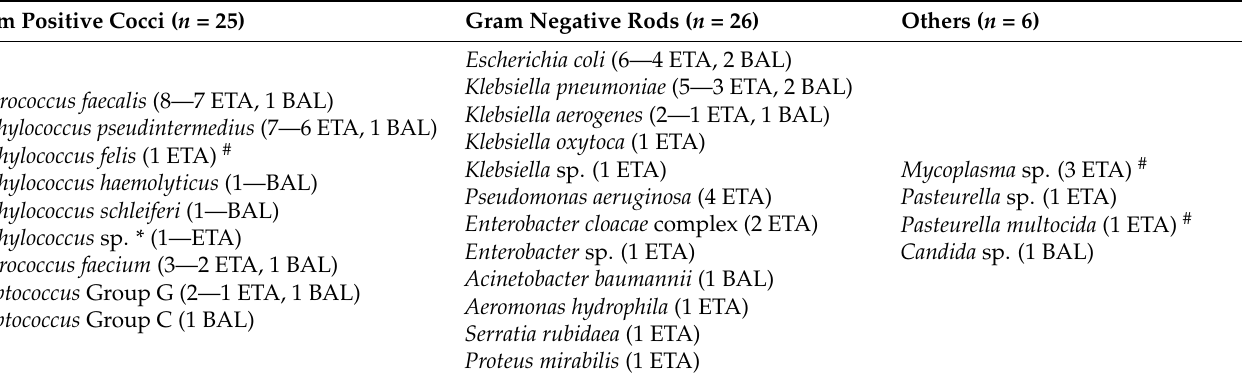
Table 1. Classification and numbers of microorganisms cultured from the airways of dogs and cats with tick paralysis during mechanical ventilation, obtained by endotracheal aspirate (ETA) or bro nchoalveolar lavage (BAL).